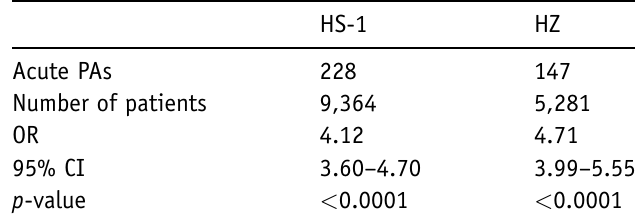
* Comparison between genders in the acute PAs and HS-1 group. Chi-square statistic is 34.6544; p- value=0.00001. Signi fi cant at p < .05. * * Comparison between Whites and African Americans in the acute PAs and HS-1 group. Chi-square statistic is 114.5746; p -value= 0.00001. Signi fi cant at p < .05. * ** Comparison between adults and children in the acute PAs and HS-1 group. Chi-square statistic is 1187.5109; p -value =0.00001. Signi fi cant at p < .05. # Comparison between genders in the acute PAs and HZ group. Chi-square statistic is 1.7093; p - value=0.19. Not signi fi cant at p < .05. ## Comparison between Whites and African Americans in the acute PAs and HZ group. Chi-square statistic is 17.9965; p -value= 0.00002. Signi fi cant at p < .05. ### Comparison between adults and children in the acute PAs and HZ group. Chi-square statistic is 6.6318; p -value =0.01. Signi fi cant at p < Table II. Prevalence of acute periapical abscesses (PAs) in herpes simplex type 1 (HS-1) and herpes zoster (HZ) patients. OR = Odds Ratio; CI = Con fi dential Interval.